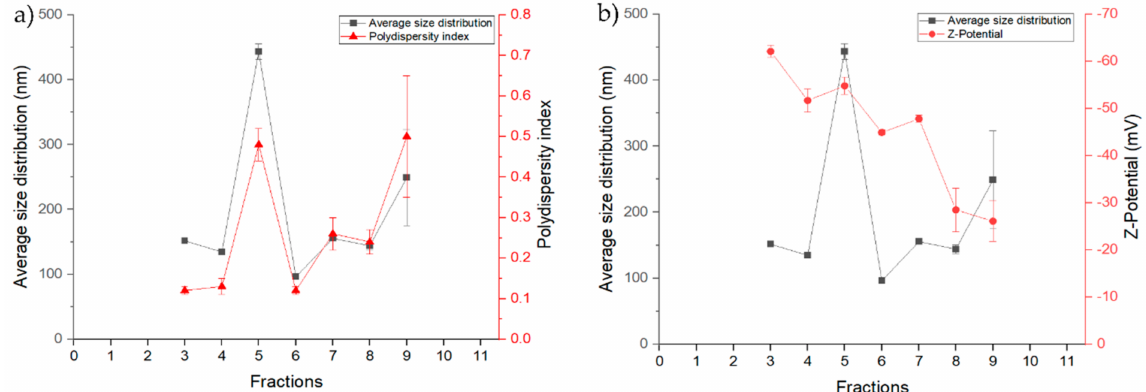
Figure 3. Characterization of CuO-NPs average size distribution, zeta potential, and polydispersity index (PDI) by Dynamic Light Scattering (DLS): ( a ) Average size distribution and Polydispersity index; ( b ) Average size distribution and